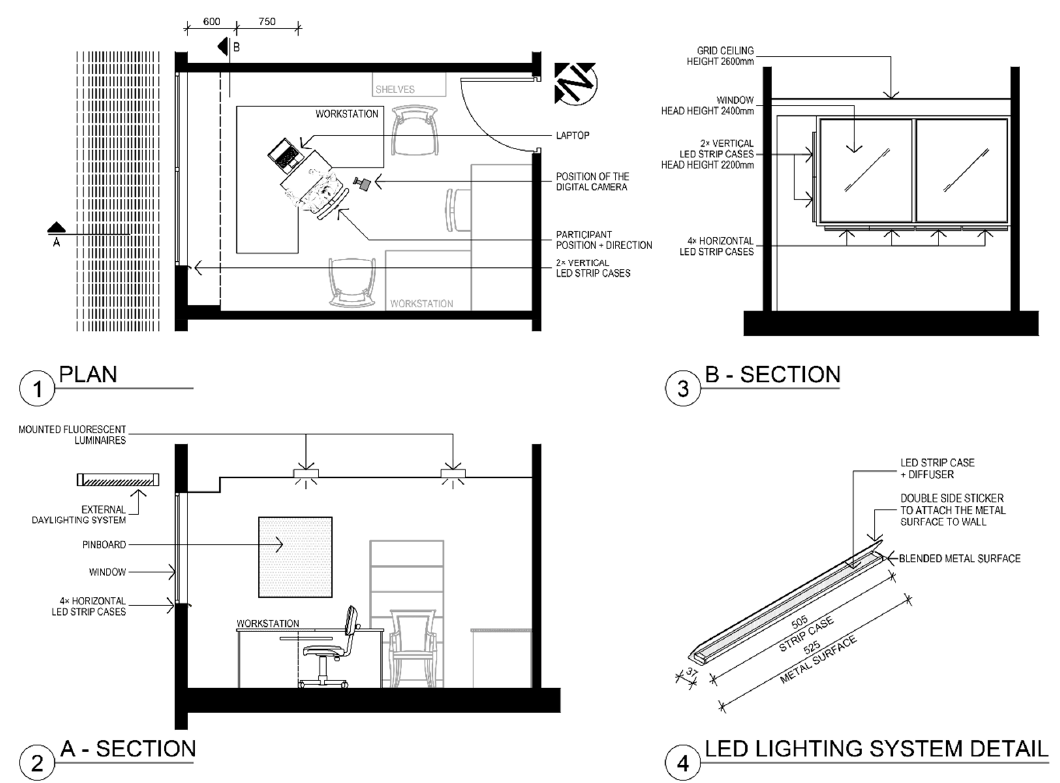
Figure 1. Plan and sections of the test office room, with details of LED lighting system placement and construction.